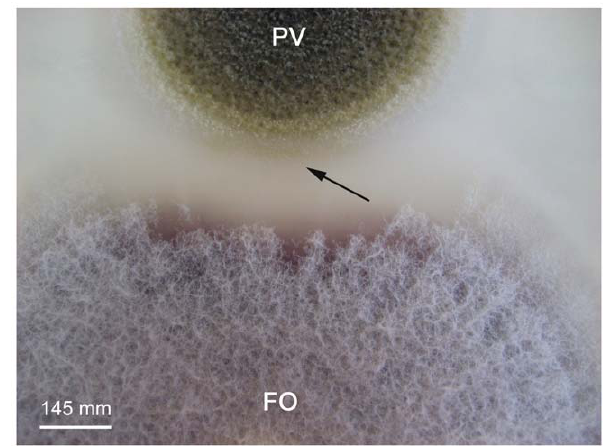
Figure 2. Antagonism between the endophytic fungus and the phytopathogen F.oxysporum in dual culture. P. variabile (PV) and F.oxysporum (FO). The two strains were placed at 25 mm of two opposite extremities of a Petri Dish on PDA medium and were observed at day fourteen. Disorganization of the phytopathogen’s mycelium structure can be observed. Arrow represents a pigmented line which could correspond to the biosynthesis of diffusible endophytic